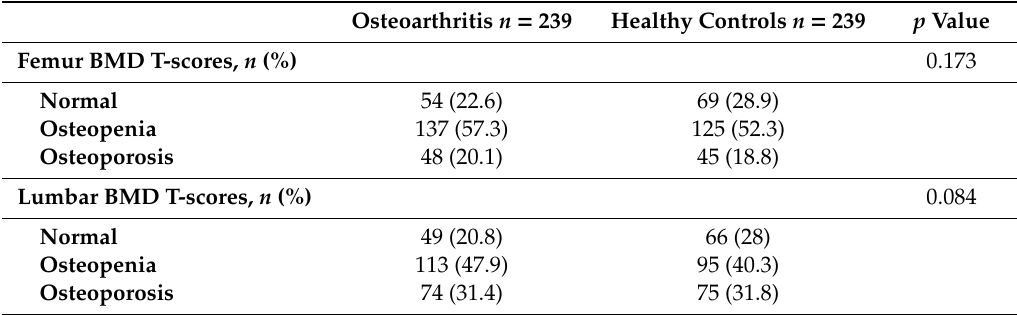
Table 2. Comparison of distributions of the BMD categories between patients with knee osteoarthritis and healthy controls.